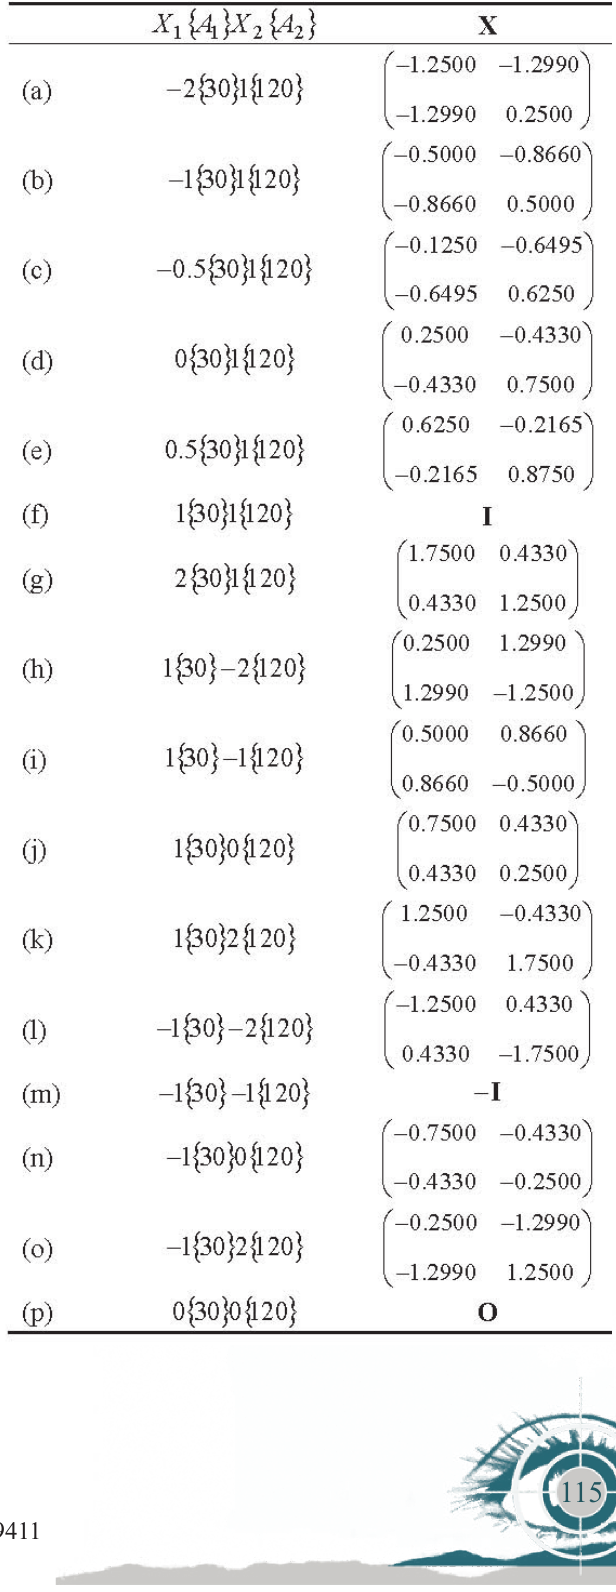
Symmetric magnifications of object O in Figure